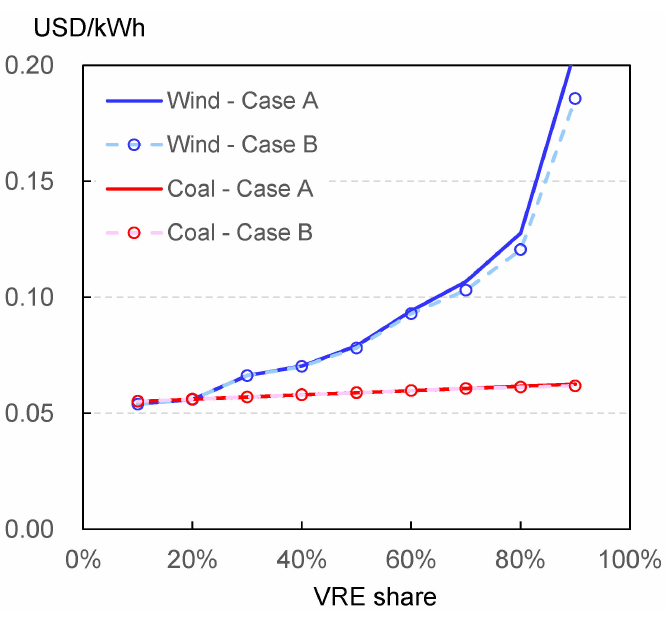
Figure 5. Marginal system